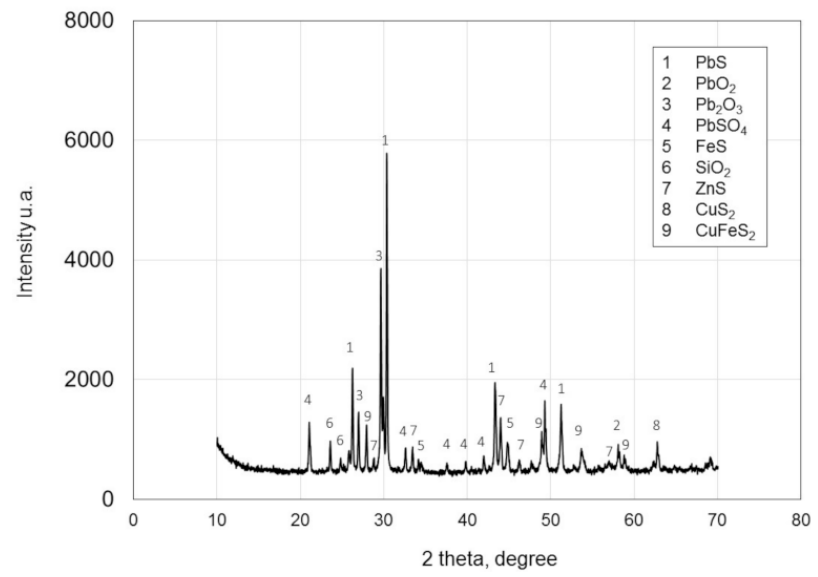
Figure 3. XRD pattern of used lead